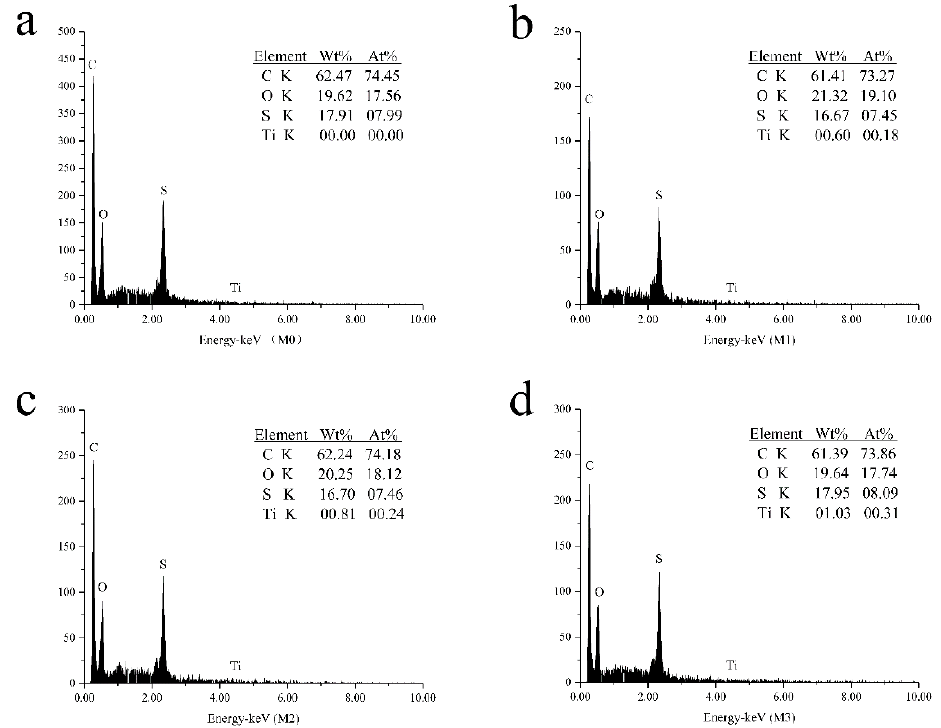
Figure 4. The energy dispersive spectroscopy (EDS) images of the neat and MXene-incorporated membranes (( a ): M0; ( b ): M1; ( c ): M2; ( d ): M3.).